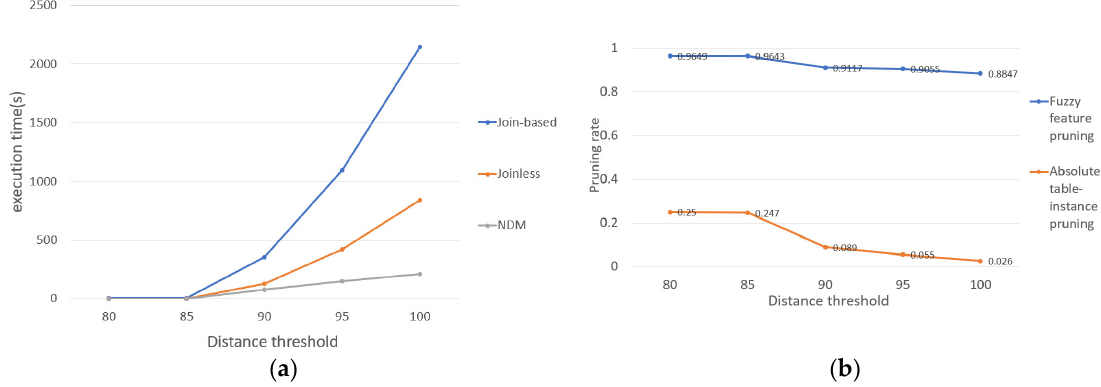
Figure 10. ( a ) Effect of the neighbor distance thresholds; ( b ) Pruning degree of the two